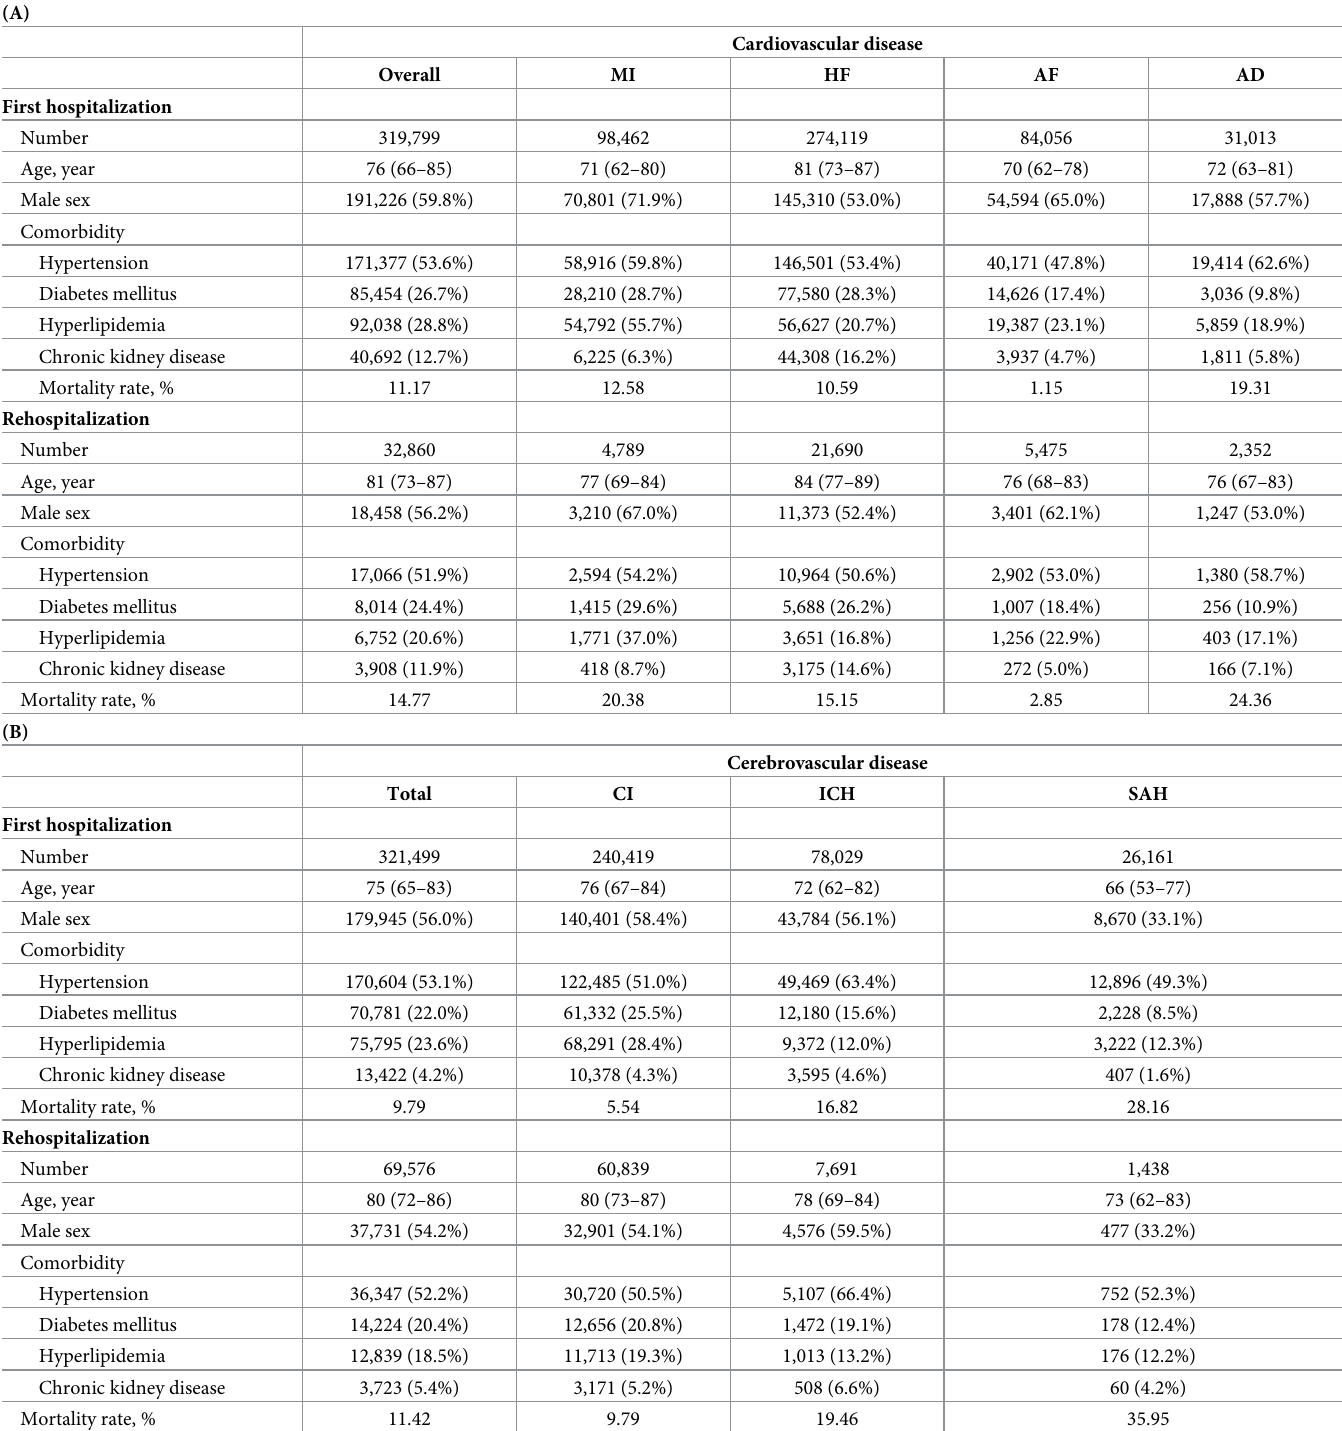
Table 3. Patient characteristics in the rehospitalization